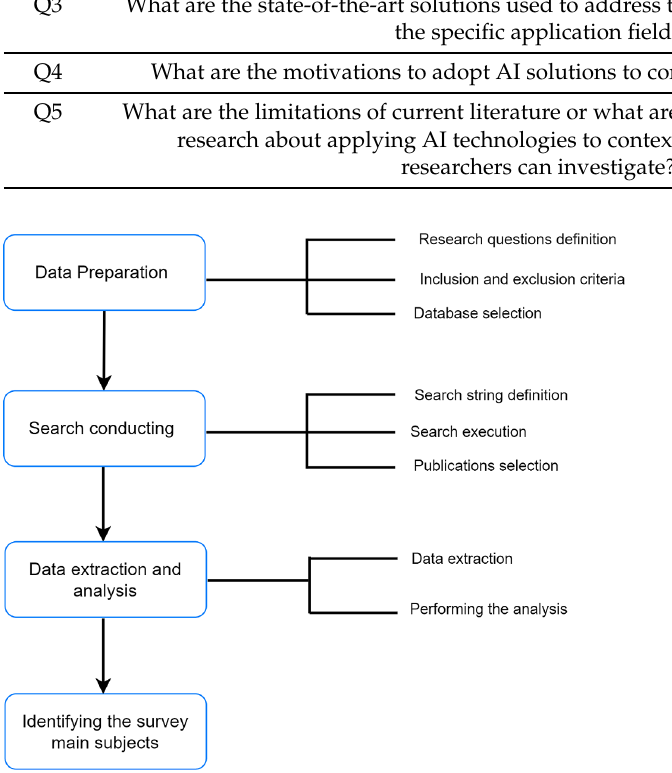
Figure 5. The main methodological phases of the